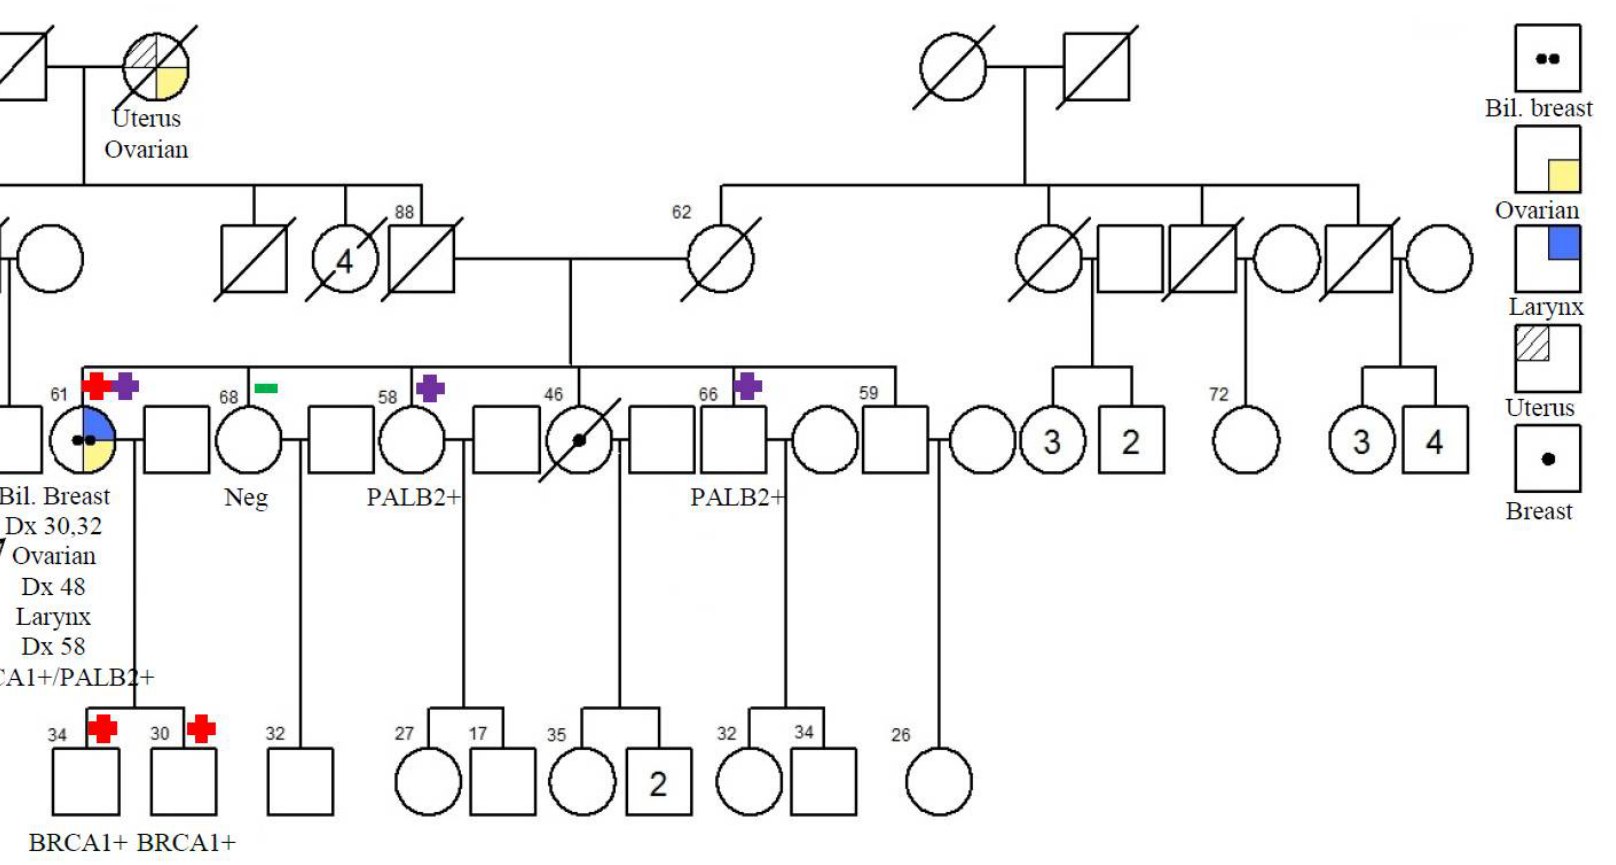
Figure 1. Pedigree of the proband’s family with double heterozygote in BRCA1 and PALB2 . BRCA1 carrier; PALB2 carrier; negative; Bil. Breast: bilateral breast.